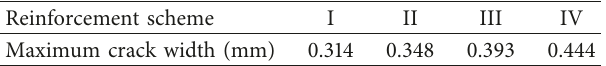
Figure 14: Crack widths in the abutment for different reinforcement schemes (mm). Table 6: Maximum crack widths in the abutment under different reinforcement